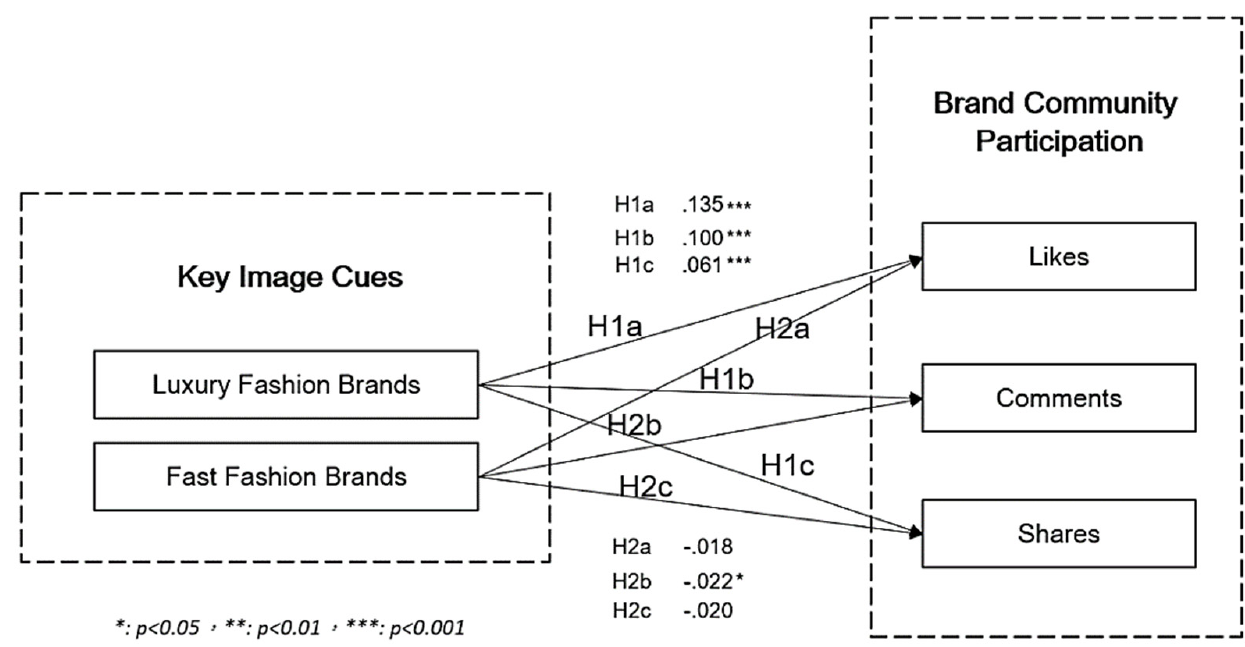
Figure 2. Model Figure 2. Model results.